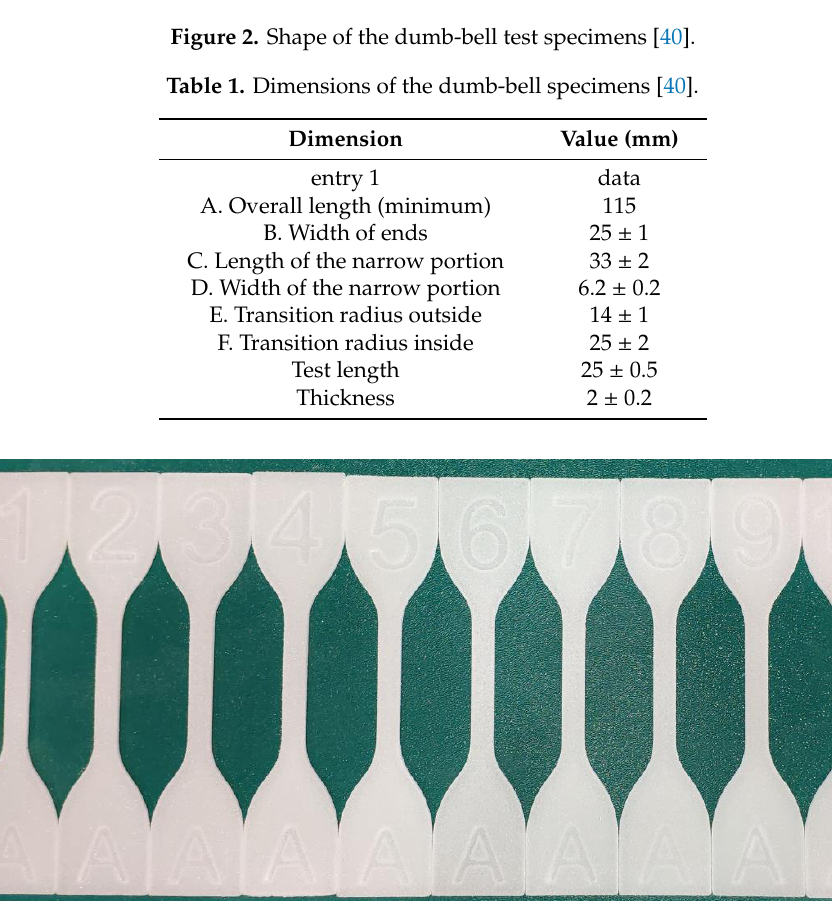
Figure 3. 3D printed dumb-bell test